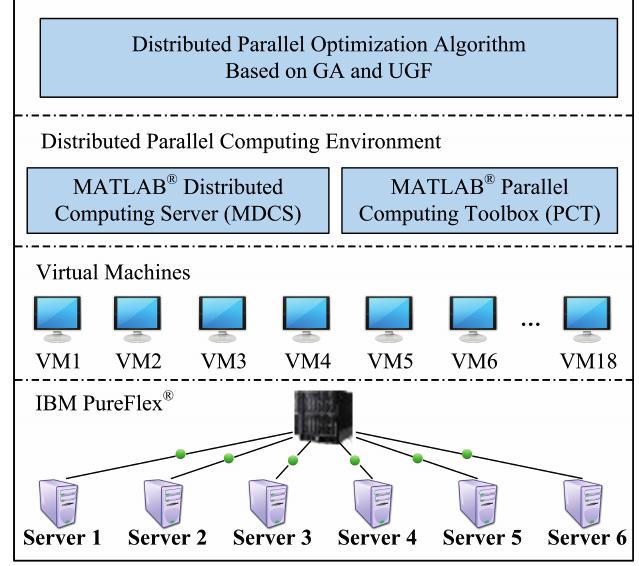
Figure 4. Cloud computing platform for the suggested algorithm execution in